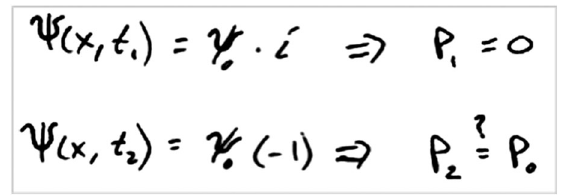
FIG. 2. A handwritten response to a version of task 1 that illustrates a common student difficulty in relating imaginary numbers to probabilities in quantum mechanics. The subscripts 0, 1, and 2 refer to instants in